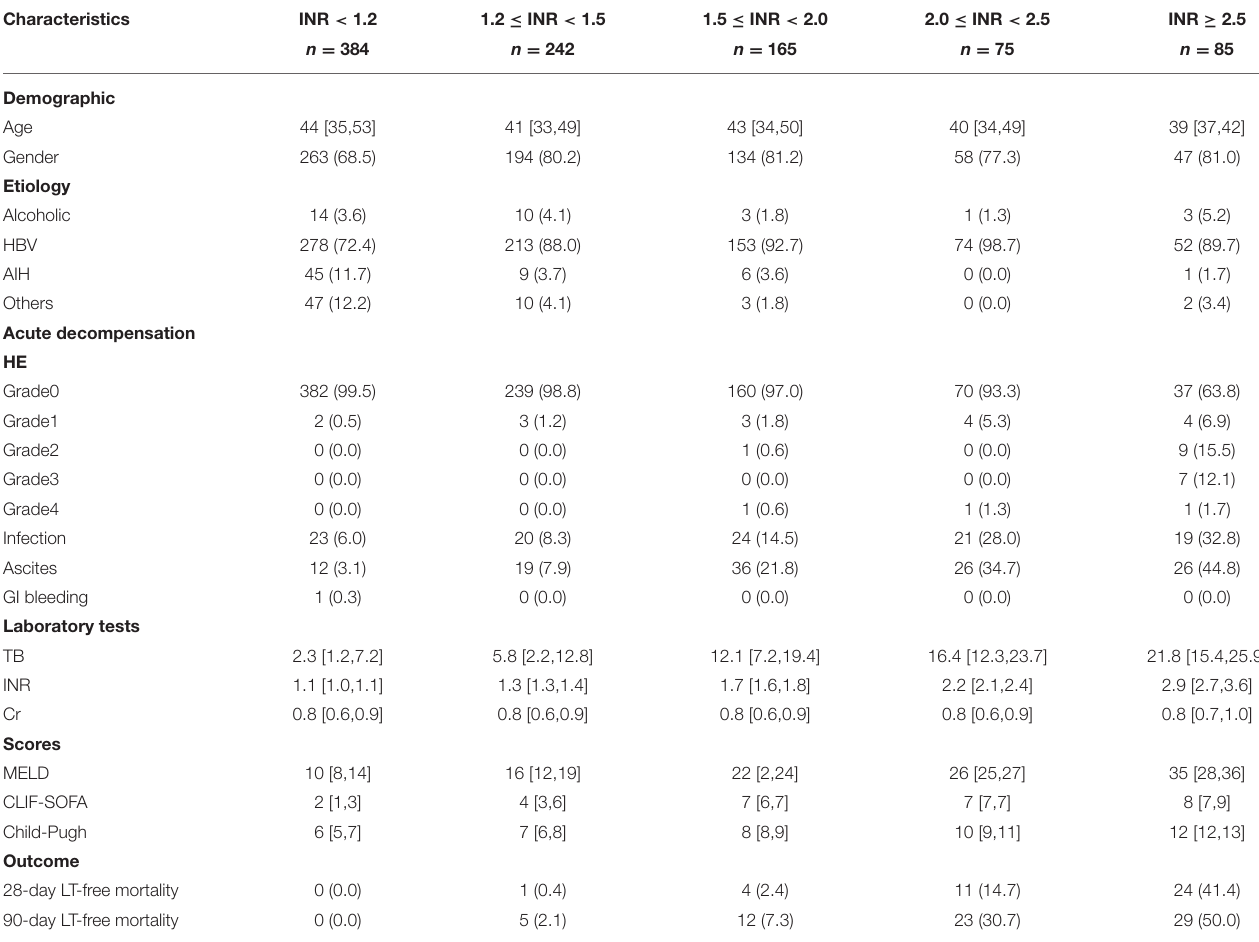
TABLE 2 | Baseline characteristics of patients with advanced fibrosis based on different INR groups at admission.